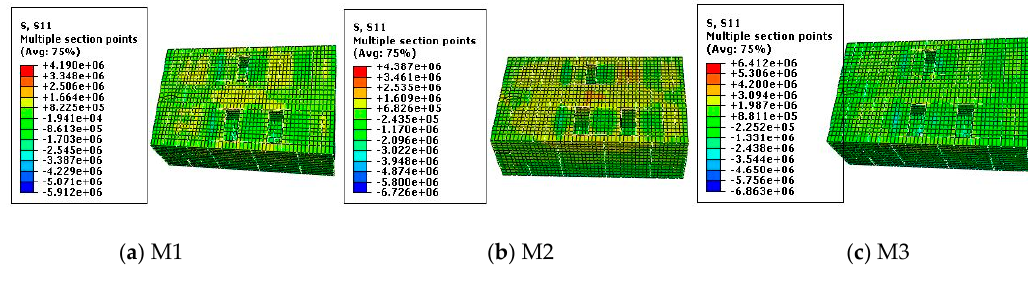
Figure 20. Stress nephograms of the underground substation. Table 8. The peak stresses and stress amplitudes under Lanzhou motion.